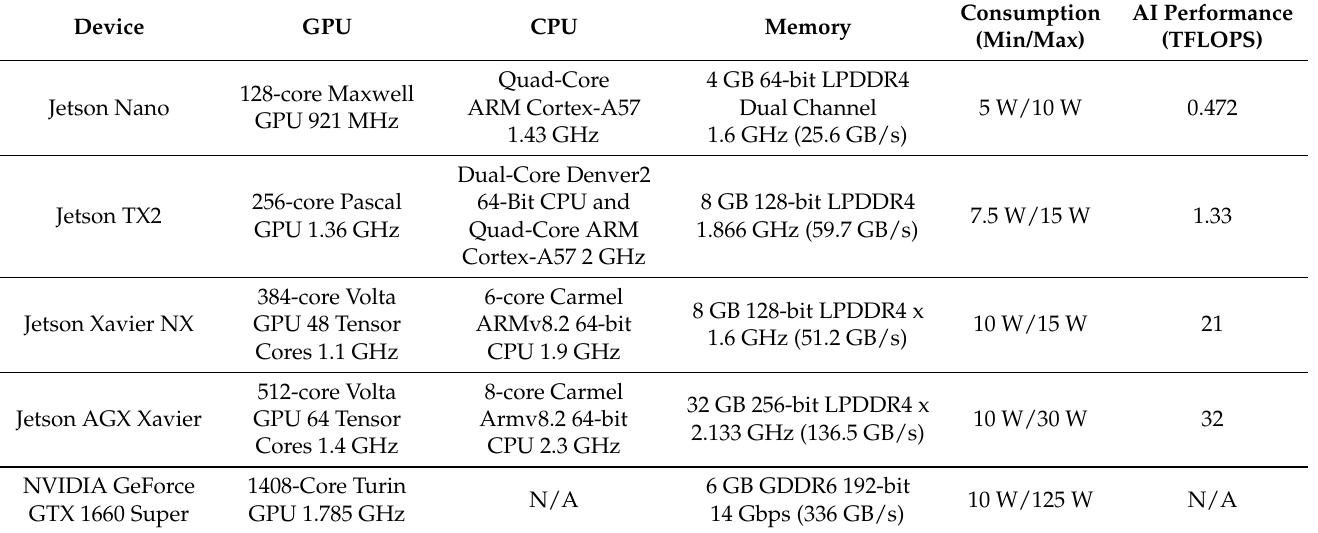
Table 2. NVIDIA Jetson devices comparison. Data obtained from https://developer.nvidia.com/ (last accessed on 28 May